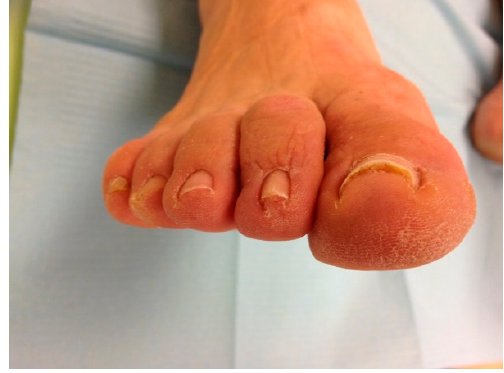
Figure 2. Initial appearance of the 1st toenail.